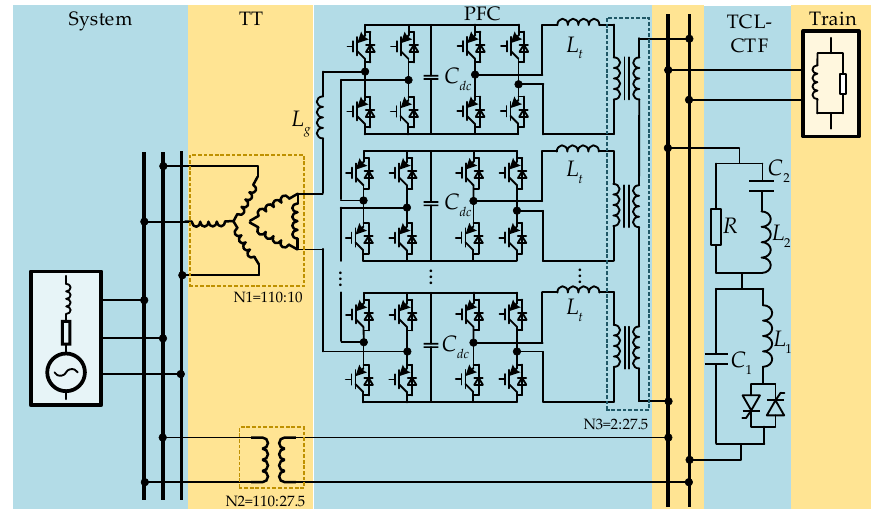
Figure 17. Diagram of compensation controlling simulation. Table 5. The parameters of the power flow controller (PFC).